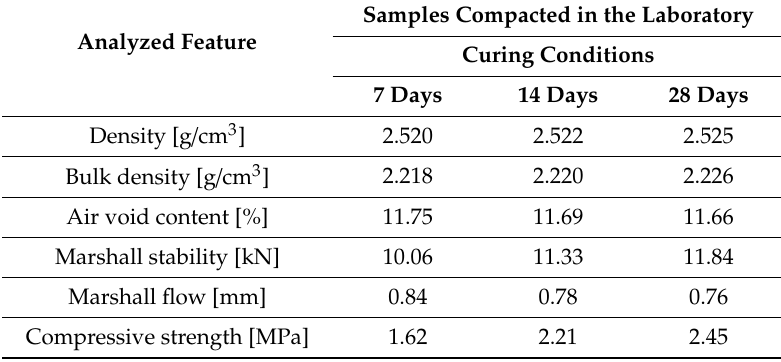
Table 4. Properties of the FAC mixture